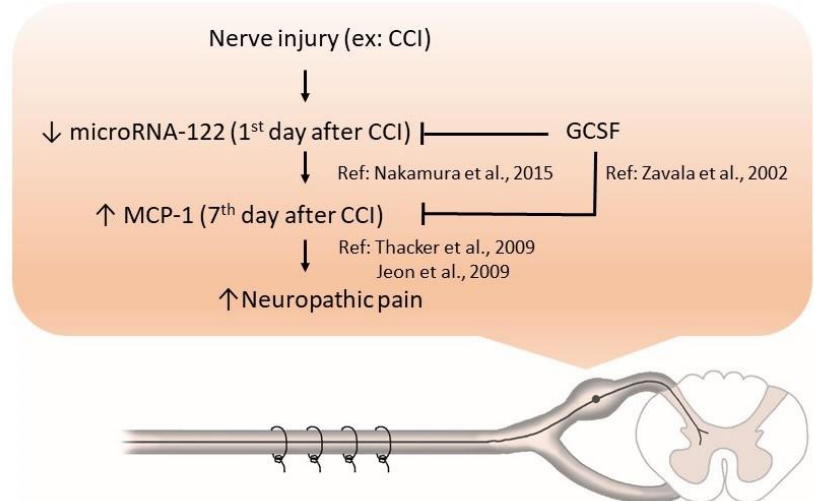
Figure 8. GCSF treatment downregulated MCP-1 expression in the DRGs of CCI rats, through upregulating microRNA-122 expression, which attenuated neuropathic pain. microRNA-122 expression was decreased in the DRGs of CCI rats; in contrast, GCSF treatment upregulated microRNA-122 expression in the DRGs in the early stage after nerve injury. GCSF itself directly, and the upregulation of microRNA-122 expression by GCSF treatment indirectly suppressed MCP-1 expression in the DRGs in the late stage after nerve injury, which further attenuated neuropathic pain. (CCI = chronic constriction injury, GCSF = granulocyte colony stimulating factor, MCP-1 = monocyte chemoattractant protein-1, ↑: increase, ↓: decrease. ).